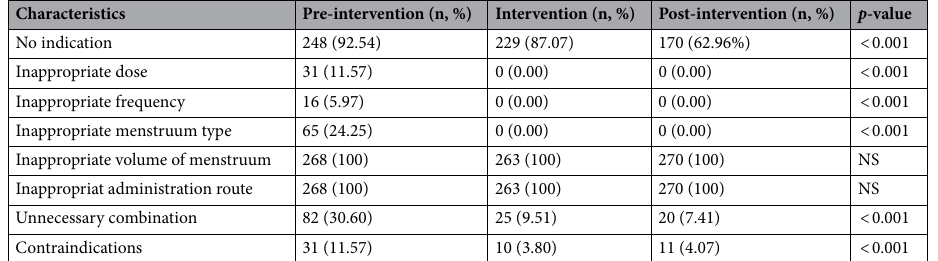
Characteristics